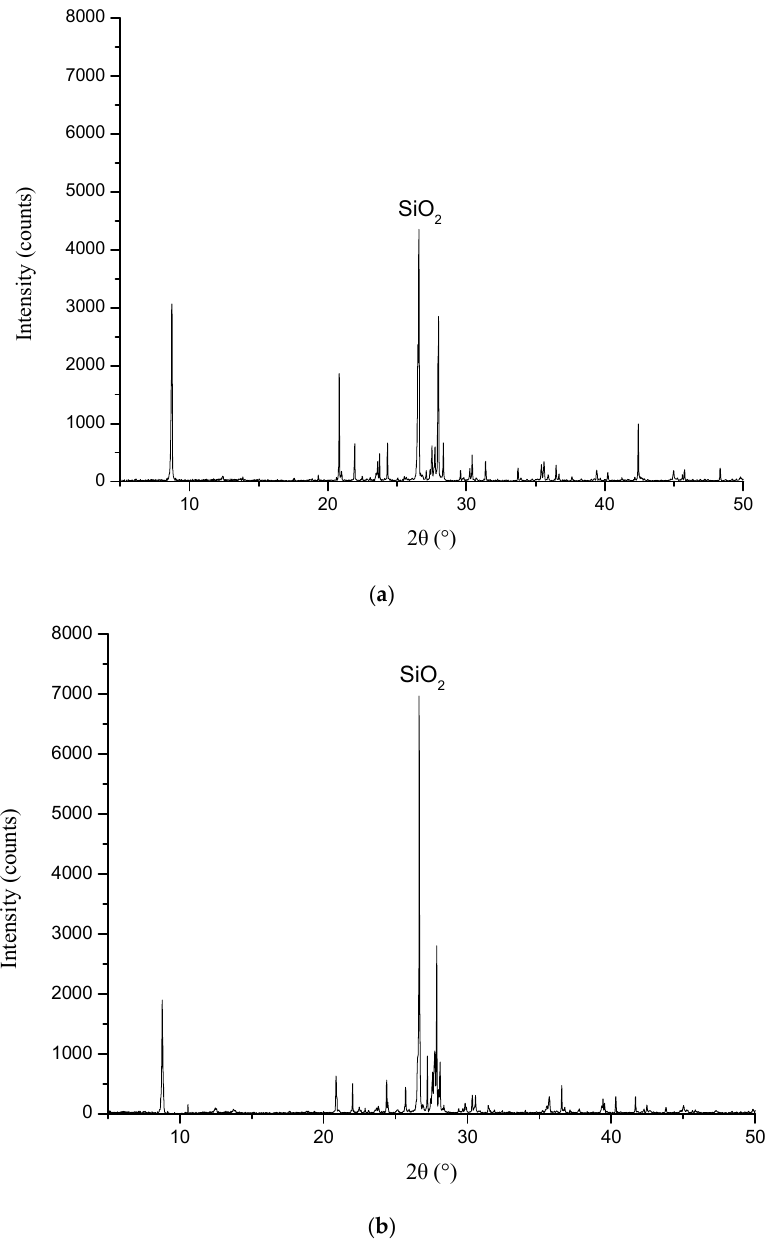
Figure 10. Powder diffraction patterns from tonalite after the treatment: ( a ) untreated (G1); ( b ) pH = 1, 60day (G2).